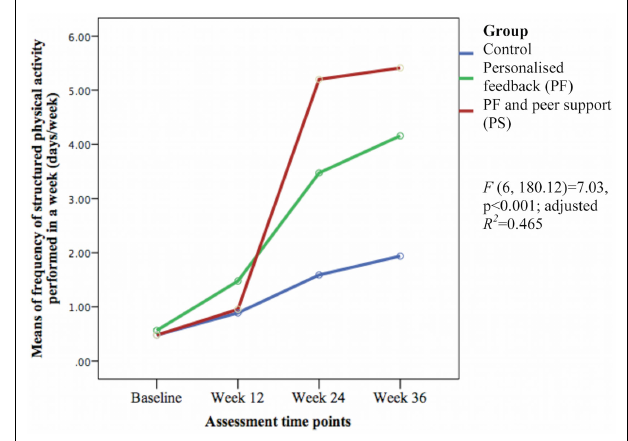
FIGURE 2 | Mean differences on daily pedometer steps between groups over time .